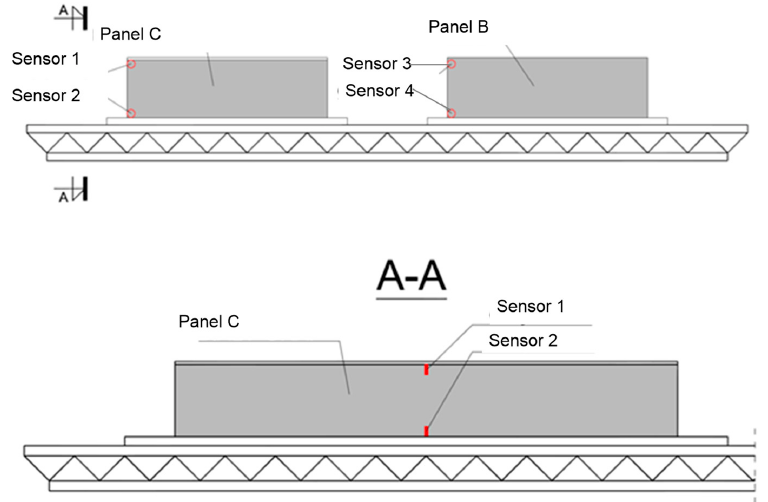
Figure 14. Schematic of the arrangement of sensors in the panels as part of temperature measurements in the samples.